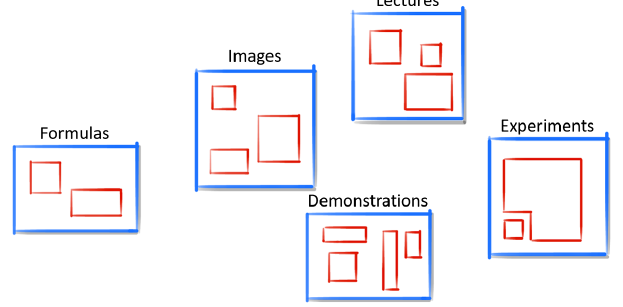
FIG. 1. Within each semiotic system, blue squares, exists many different semiotic resources, red squares.